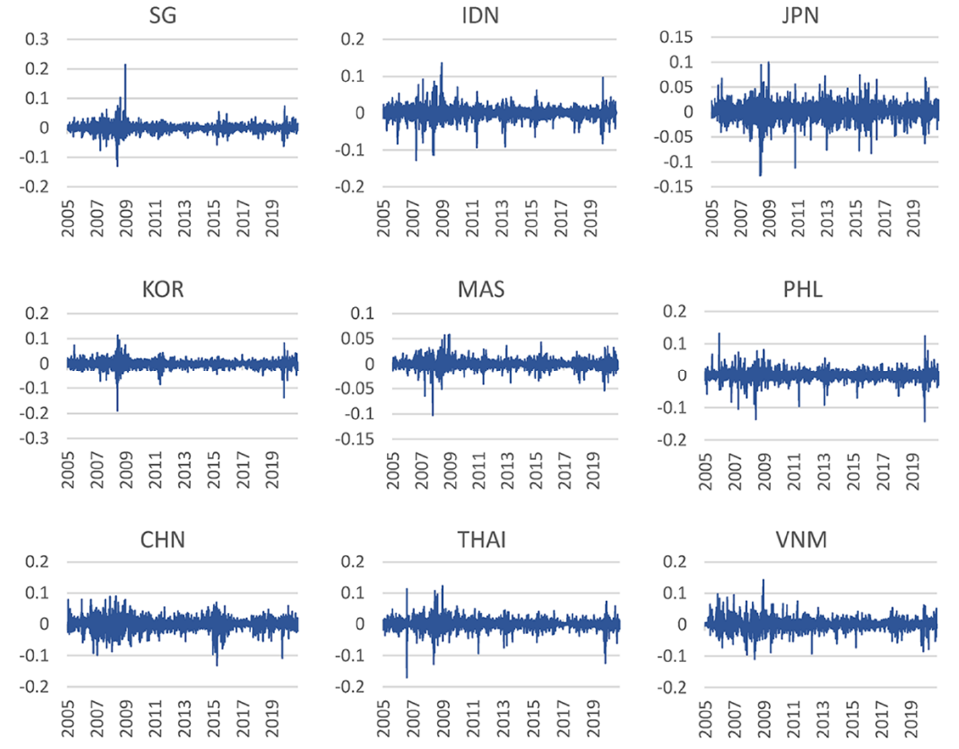
Figure 1. Dynamics of stock market returns for ASEAN+3. Table 1. Unit root tests and descriptive statistics of stock market indices